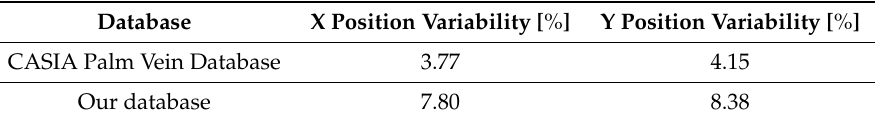
Table 2. Comparison of hand position variability.